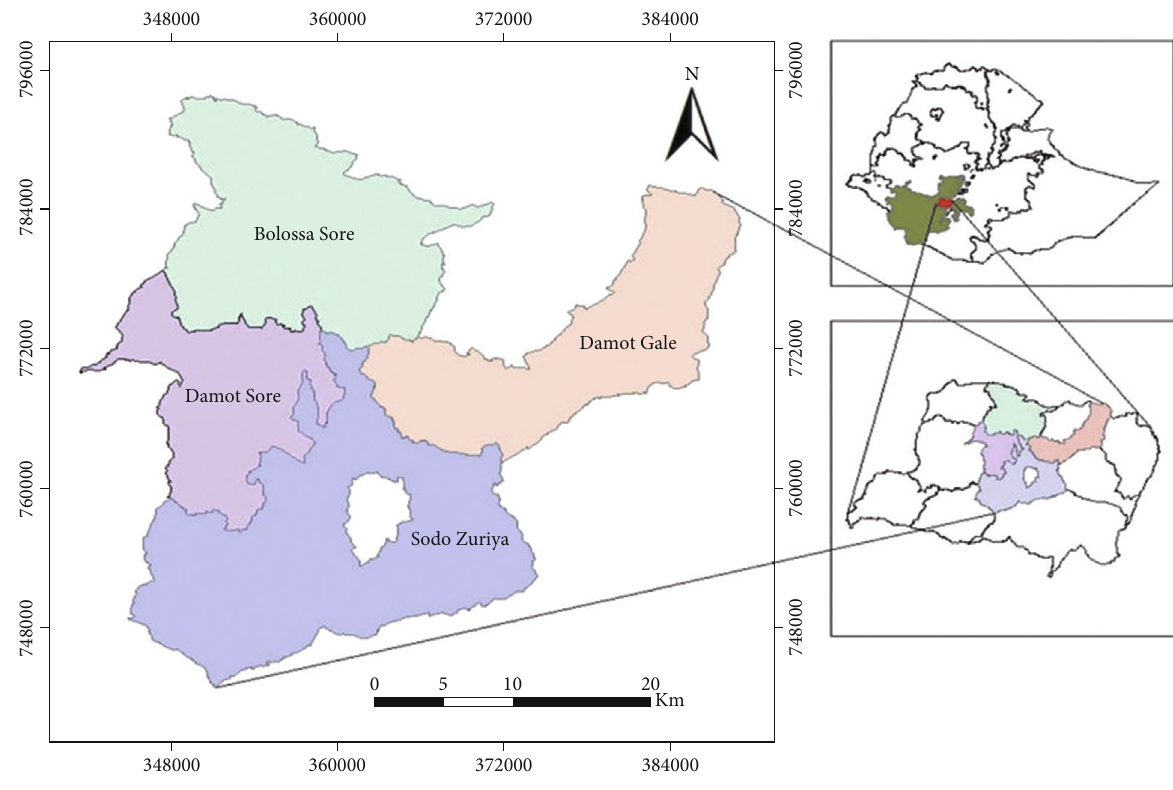
Figure 2: Map of the study area. Table 1: Proportion of Trypanosoma species in the study